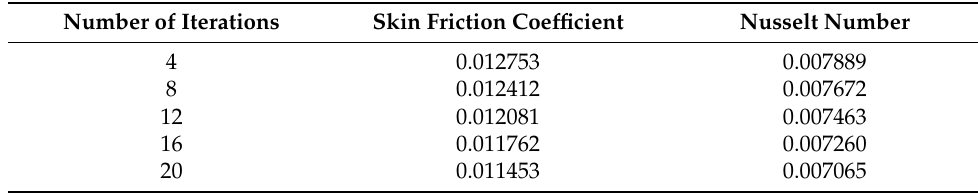
Table 1. Convergence of HAM solutions.